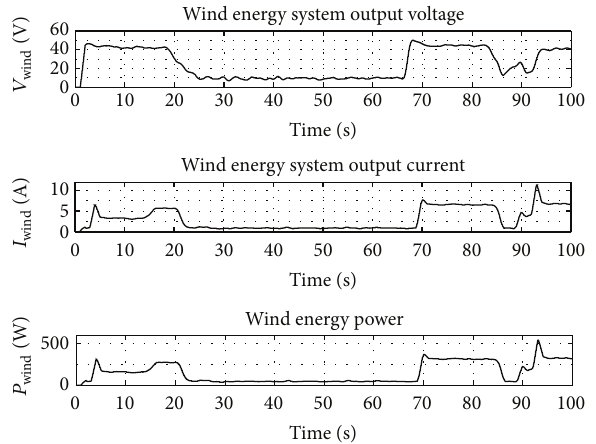
Figure 16: Voltage, current, and power variations of WES for case 1.